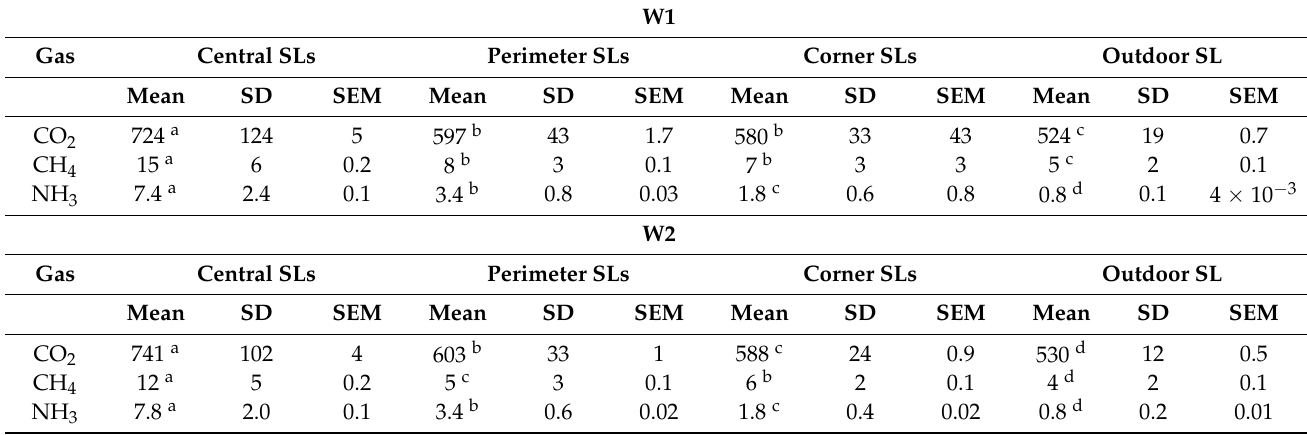
Table 1. Mean values of gas concentrations (ppm) of carbon dioxide (CO 2 ), methane (CH 4 ) and ammonia (NH 3 ) with related standard deviations (SD) and standard error of mean (SEM) for the sampling location (SL) groups in week 1 (W1) and week 2 (W2). Groups of values that do not share a letter (a, b, c, d) are significantly different within each